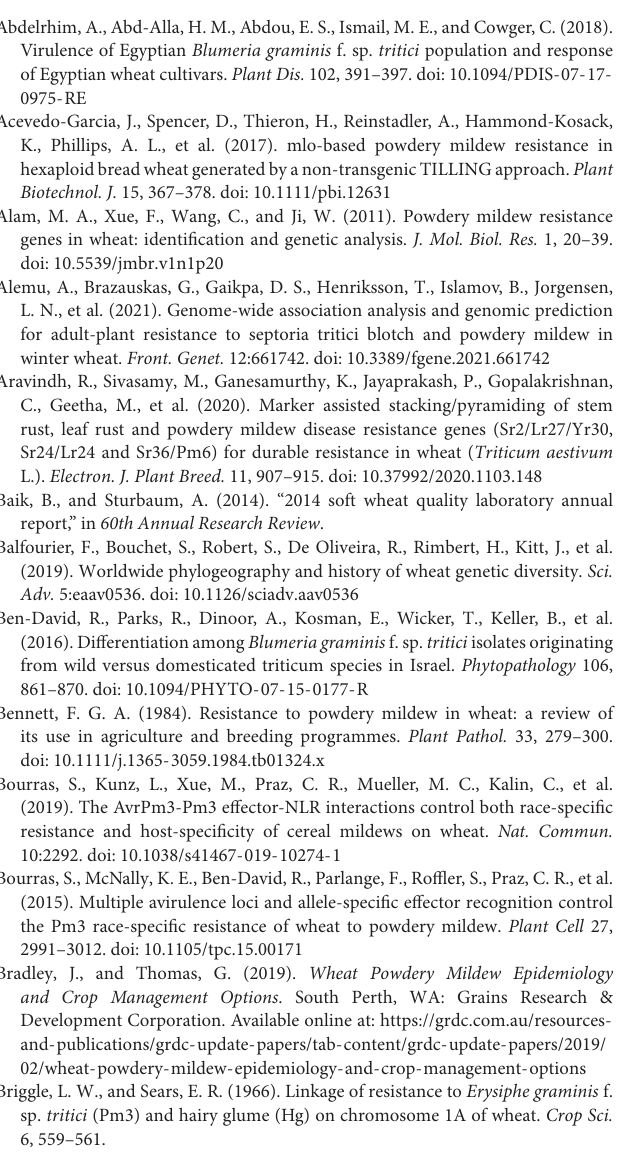
Supplementary Figure 3 | Complexity of virulence to wheat resistance genes among Blumeria graminis f. sp. tritici populations from five global regions compared to previously published data from the United States and Egypt, for (A) ten older Pm genes, in commercial use for a longer time ( Pm1a – Pm17 ) and (B) nine newer Pm genes, more recently introgressed into hexaploid wheat from wild relatives ( Pm25 – Pm53 ). Virulence complexity was calculated as mean percentage of Pm genes to which isolates were intermediately virulent (yellow) and fully virulent (red). Within a panel, countries topped by the same letter did not have significantly different virulence complexities ( P < 0.05); numbers below countries indicate the number of isolates analyzed. Error bars indicate standard error of the means. Table 1 ). x Western Siberia region: Isolates from Karabalyk, Kazakhstan were grouped with those from Russia (refer to Table 1 ). y Cowger et al. (2018). z